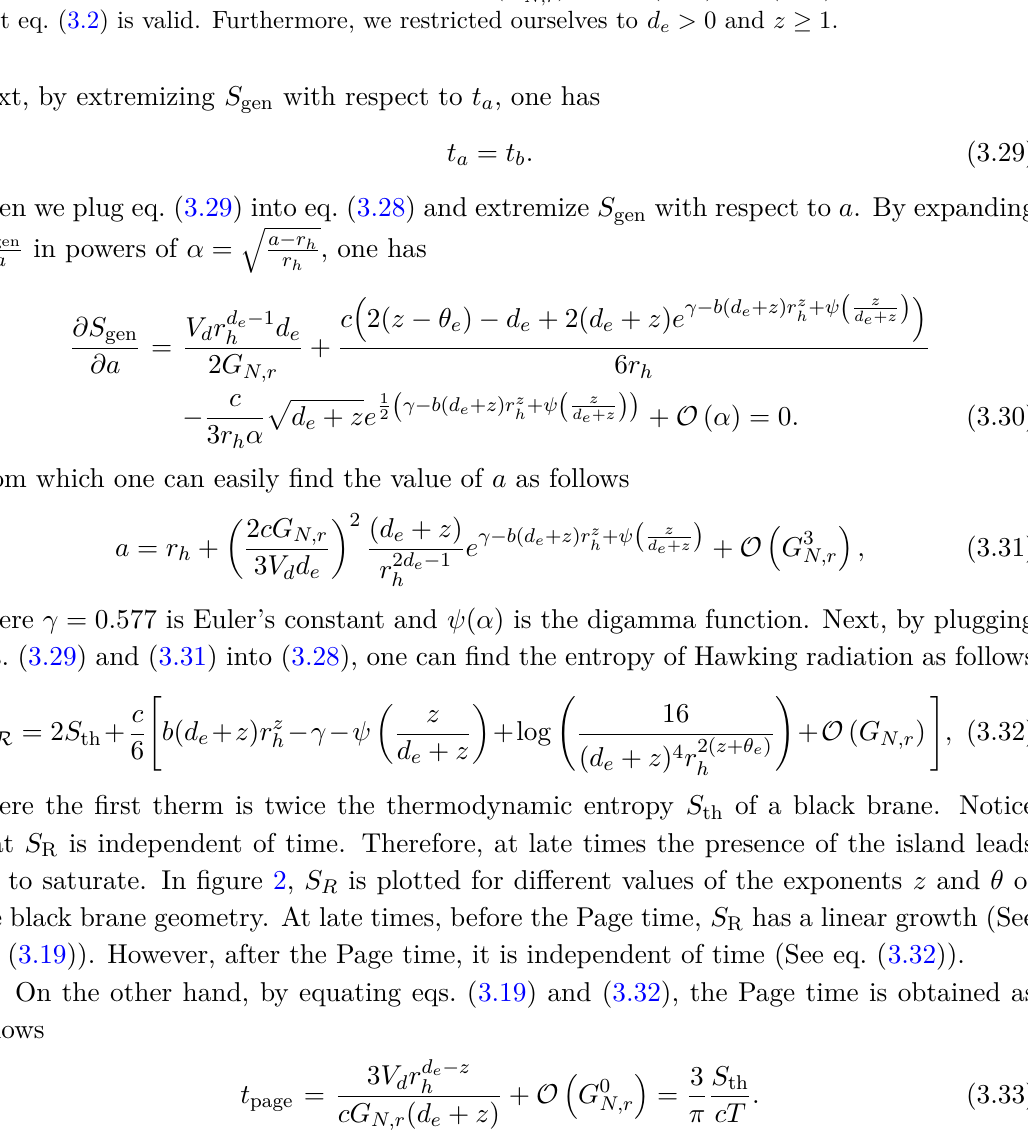
Figure 2 . Entropy of Hawking radiation S R when the matter is described by a CFT d +2 or a holographic HV QFT with θ = 0 for: ( Left ) d = 2 , θ = − 1 and different values of z . ( Right ) d +2 m d = 3 , z = 1 and some values of θ . Before the Page time, S R grows linearly with time. However, it saturates to 2 S after this time. Here we set c = A = V = r = 1 and G = 0 . 001 . It should be th d h N,r pointed out we omitted the correction of order O ( G 0 ) in eqs. (3.32) and (4.29), since we N,r